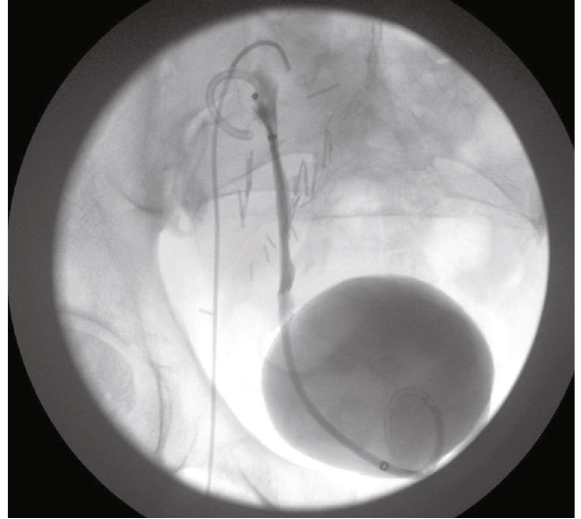
Figure 4: Posttransplant day 72 nephrostogram with placement of double J stents and removal of percutaneous nephrostomy tube with free fl ow of contrast in the bladder